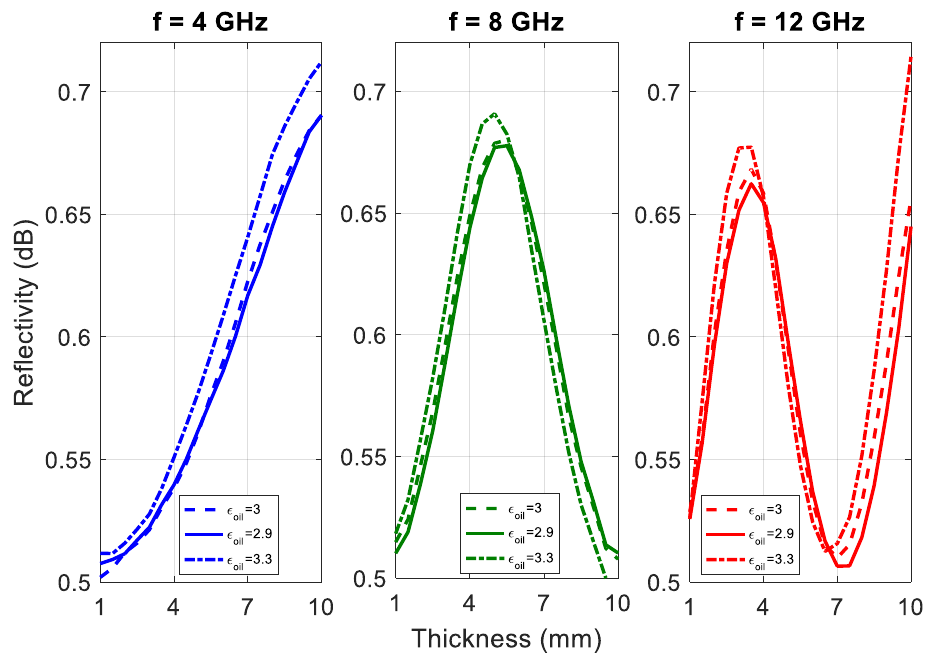
Figure 4. Comparison between the probability of detection versus the oil thickness (in mm) for single-frequency detectors at 4 GHz, 8 GHz and 12 GHz, using single observation ( M = 1) and different oil properties. The electromagnetic roughness is ks =